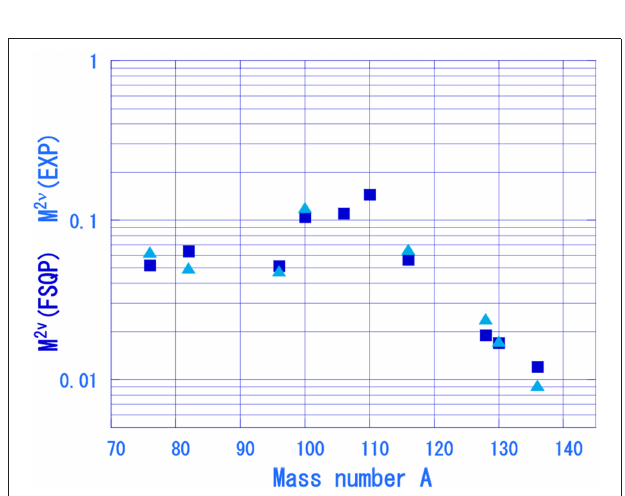
FIGURE 7 | Two neutrino DBD NMEs M 2 ν [3, 12]. Triangles: experimental NMEs. Squares: FSQP NMEs.